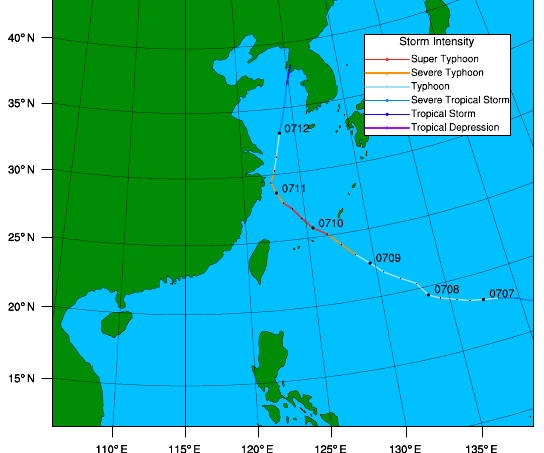
Figure 1. Model domain and best track of the typhoon.